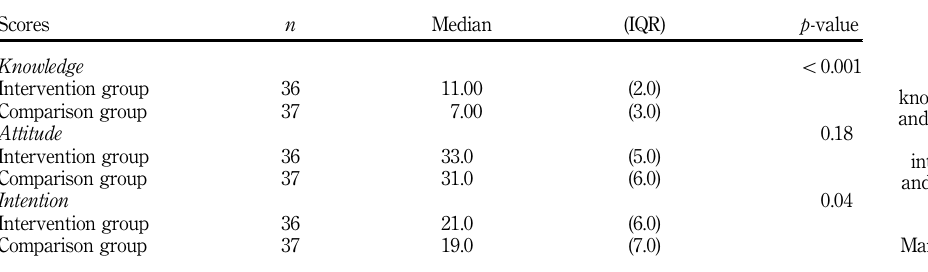
Table III. Comparison of knowledge, attitude, and intention scores between the intervention group and the comparison group after intervention by Mann – Whitney